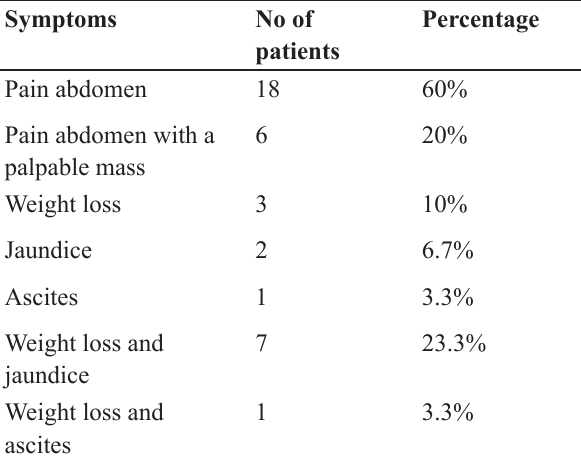
Table 1: Presenting symptoms Symptoms